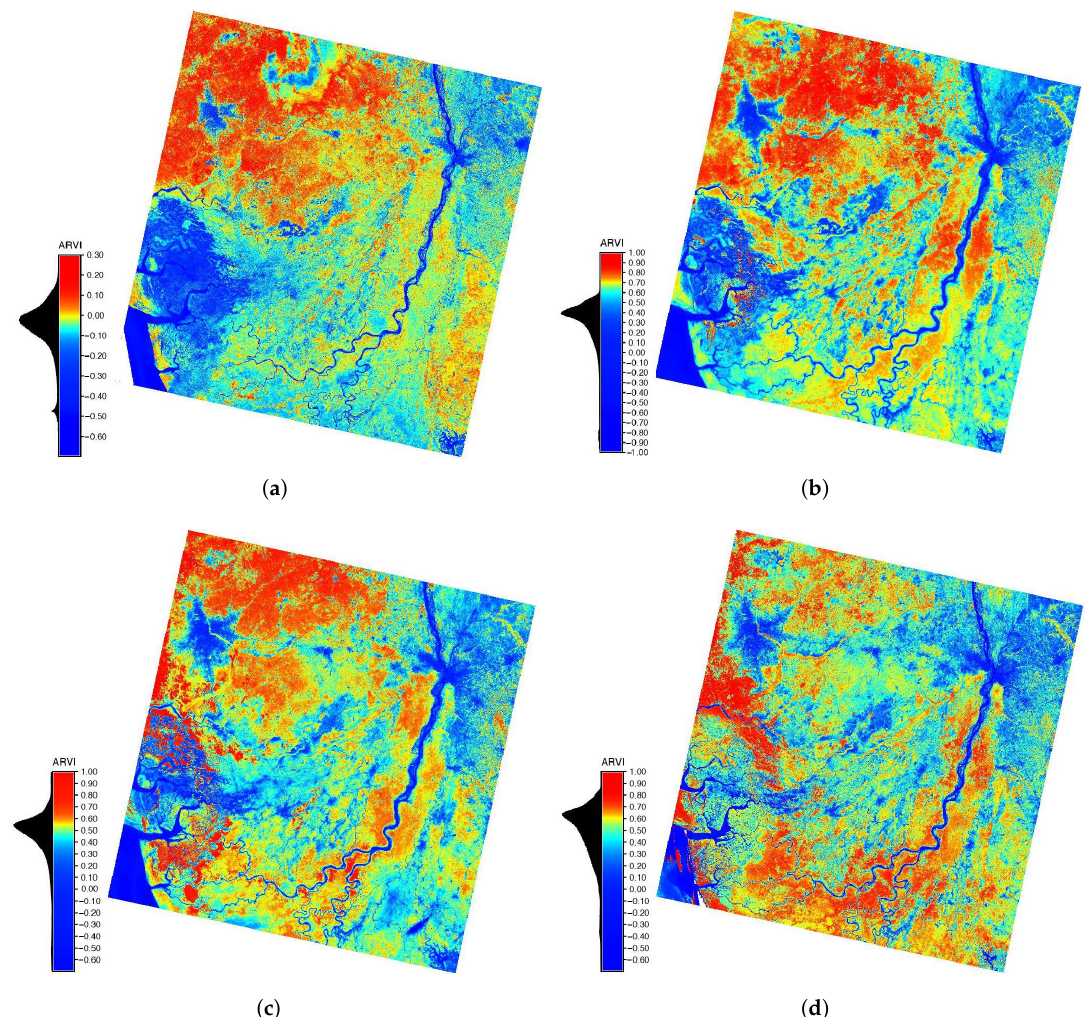
Figure 4. ARVI computed from the Landsat 8-9 OLI/TIRS images of Niger River Delta for four years: ( a ) 2013, ( b ) 2015 ( c ) 2021, ( d )